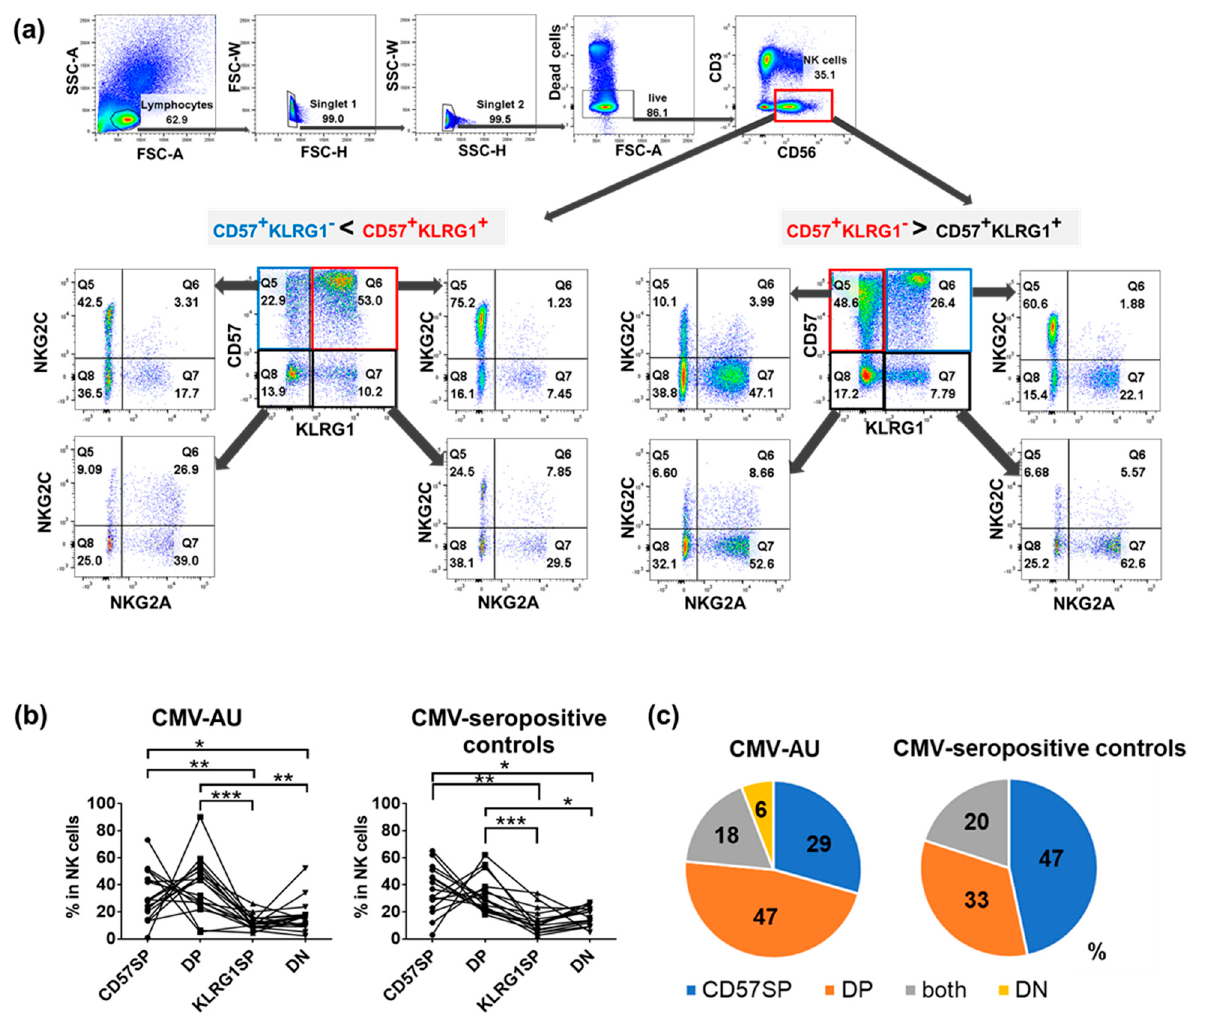
Figure 2. Expansion of the CD57 + KLRG1 − or the CD57 + KLRG1 + subsets among the four natural killer (NK) cell subsets distinguished by the differential expression of CD57 and KLRG1. ( a ) Identification of four NK cell subsets as determined by differential expression of CD57 and KLRG1. Representative profiles of two CMV-seropositive healthy individuals with expansion of either the CD57 + KLRG1 + or CD57 + KLRG1 − NK subset. Notably, NKG2A and NKG2C are expressed at different levels on each subset. ( b ) Frequencies of the four NK subsets are shown for each individual. ANOVA: CMV-AU, p = 0.0025; CMV-seropositive controls, p = 0.002. * p < 0.05, ** p < 0.01, *** p < 0.001. ( c ) The proportions of NK cell subsets most expanded in the CMV-AU and CMV-seropositive healthy individuals. CMV-AU: n = 17, CMV-seropositive controls: n = 15.